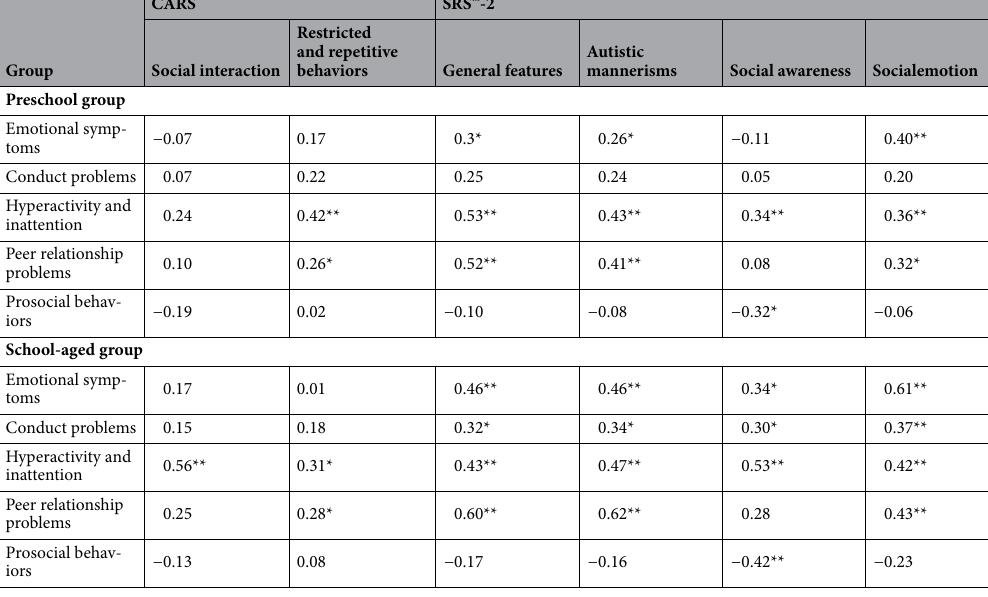
Table 3. The correlations of the five subscales of the SDQ with the subscales of both the CARS and the SRS™- 2. (N = 108). * p < . 05; ** p < . 01, CARS: Childhood Autism Rating Scale, SRS™-2: Social Responsiveness